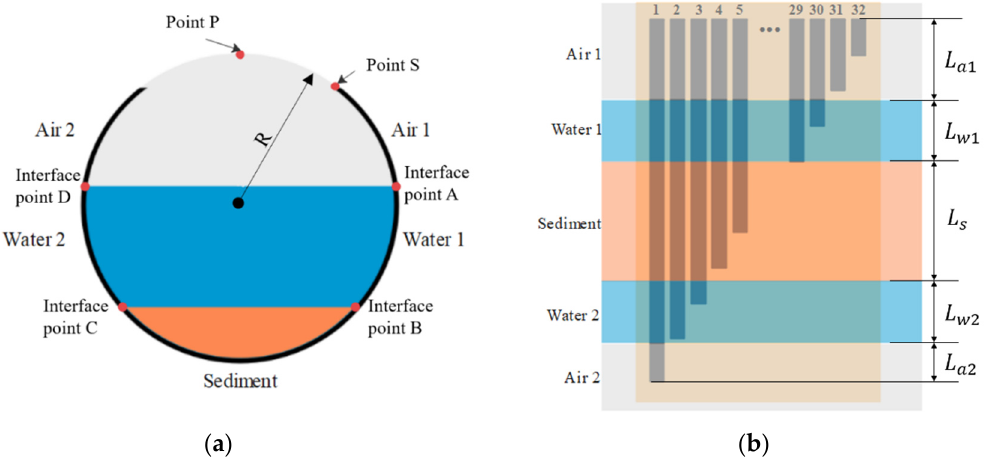
Figure 3. ( a ) Cross section view of the sensor attached on the pipe inner wall; ( b ) five-phase media along the sensor.